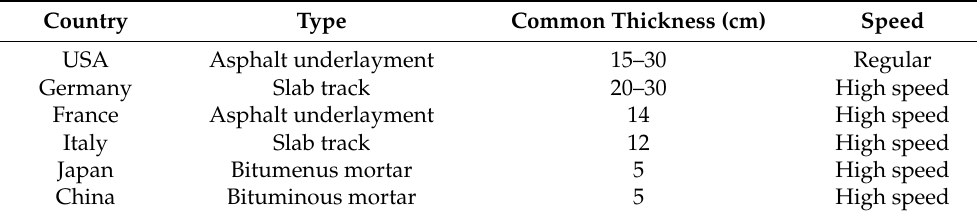
Table 7. Various applications of asphalt and bituminous materials under railways.